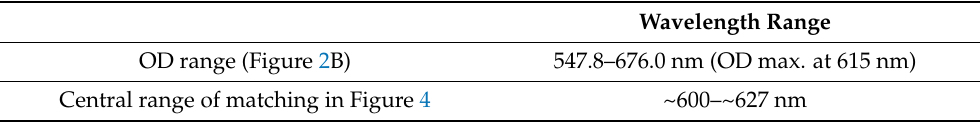
Table 1. Wavelength ranges used for OD calculation and for two phases